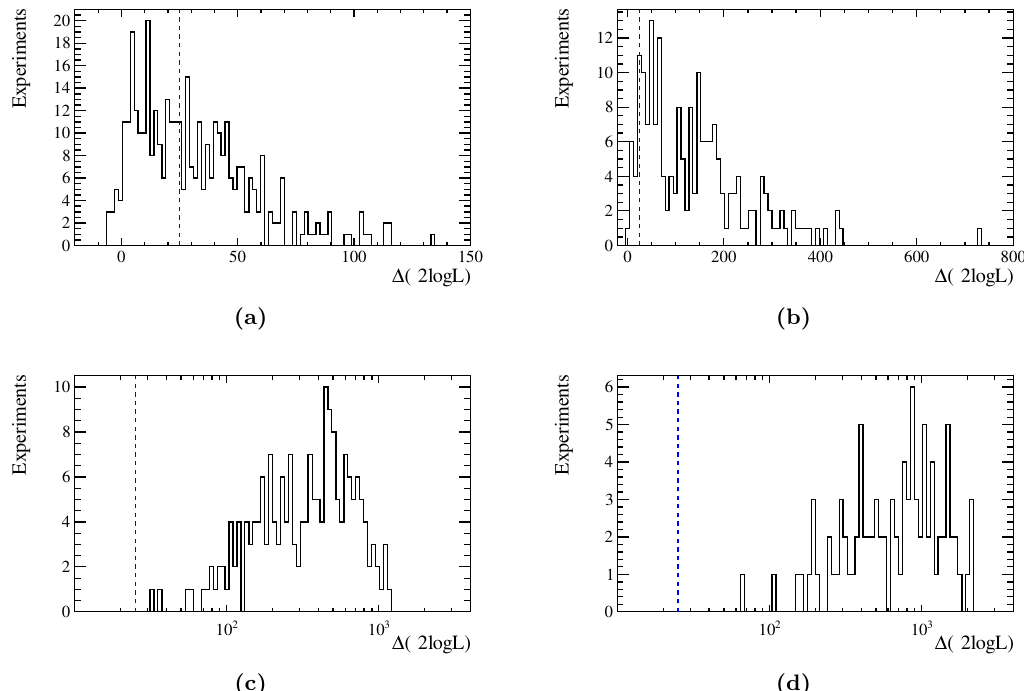
Figure 6 . Di(cid:11)erence in (cid:0) 2 log L between the two solutions for (cid:30) 00 LHCb (b) 10 ab (cid:0) 1 at Belle II (c) Run 3 data at LHCb (d) 50 ab (cid:0) 1 at Belle II. The vertical dashed line indicates the cut-o(cid:11) at which a 5 (cid:27) distinction is achieved. Note the log scale on the bottom